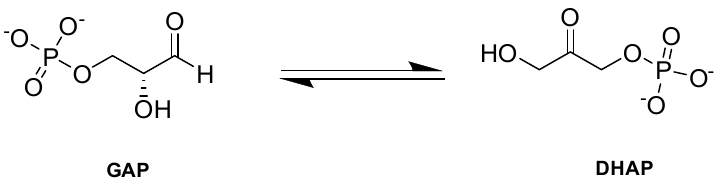
Figure 10. TPI-catalyzed reaction.